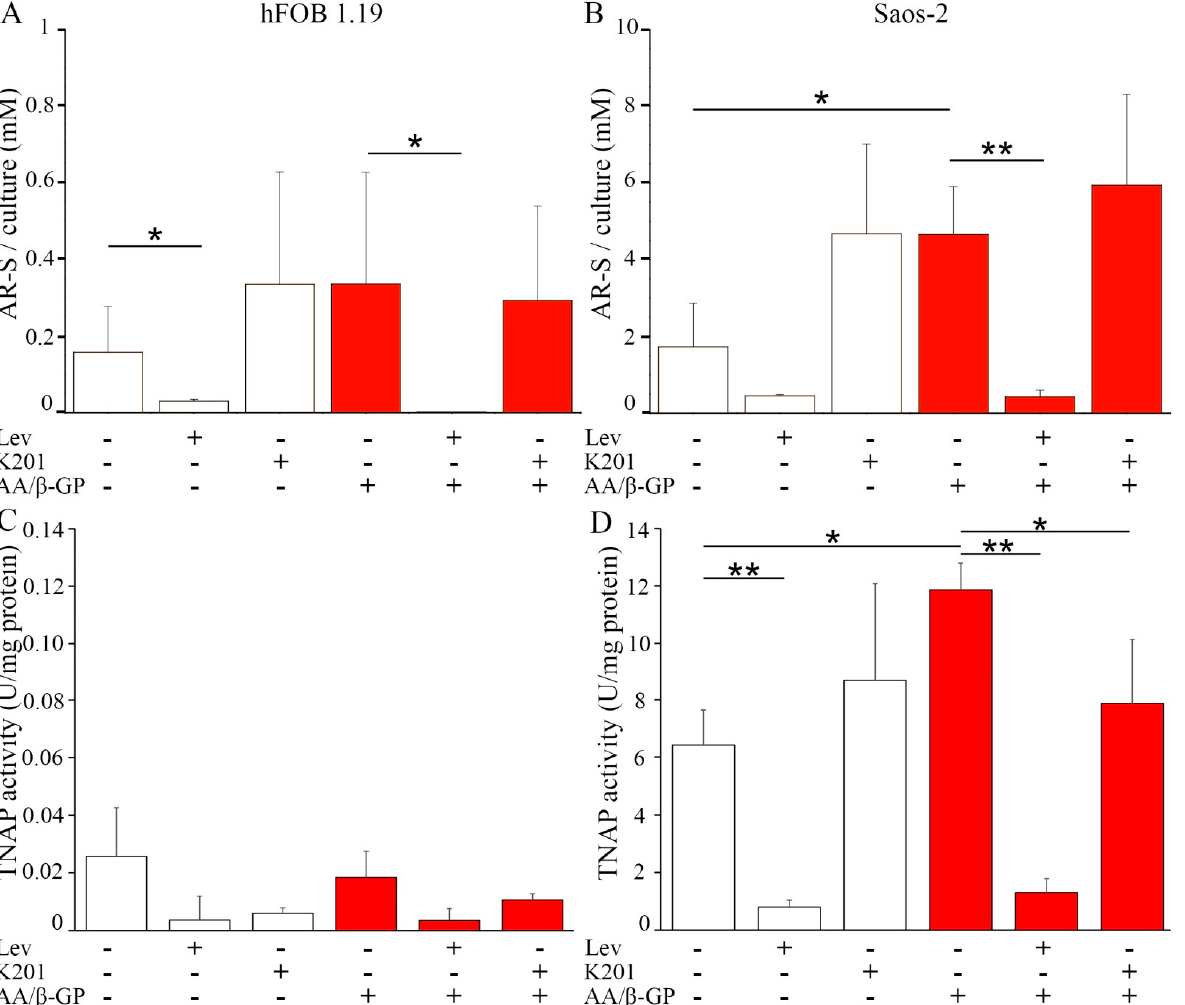
Figure 2. Mineralization level of hFOB 1.19 ( A , C ) and Saos-2 ( B , D ) cells in resting conditions (white) or after seven-day stimulation with AA and β -GP (red). Cells were either non-treated ( − ) or treated (+) with inhibitors: 100 µM levamisole (Lev) for Tissue non-specific alkaline phosphatase (TNAP) activity or 25 µM K201 for Ca channel activity. Ca salts ( A , B ) were stained with alizarin red-S (AR-S) dissolved in cetyl pyridinium chloride (CPC), and their content was measured spectrophotometrically at λ 562 nm. TNAP activity ( C , D ) was measured using alkaline phosphatase (ALP) Yellow para- nitro phenyl phosphate (pNPP) Liquid Substrate System for ELISA (Sigma-Aldrich, Warsaw, Poland), and absorbance was recorded spectrophotometrically at λ 405 nm. Data are means ± s.e. of at least three experiments; * p < 0.05 and ** p < 0.01.